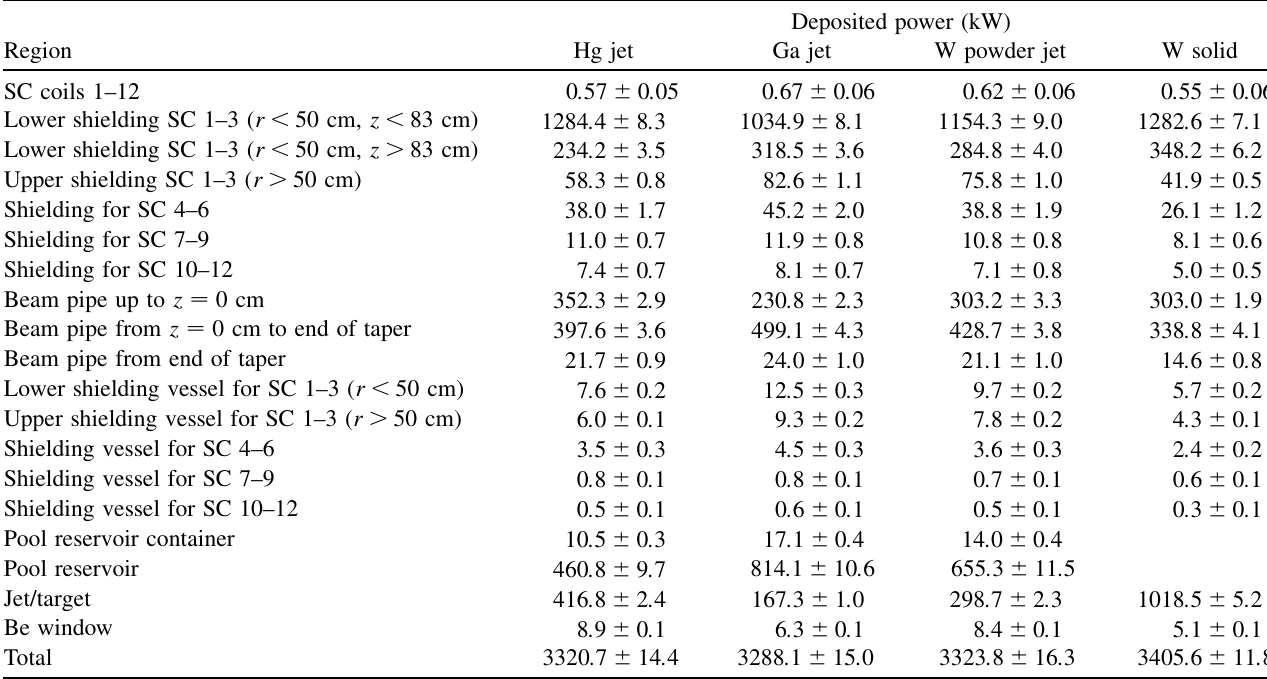
TABLE II. Power deposition in various regions of the increased shielding geometry configuration for the mercury jet, as well as for alternative target materials. For the solid tungsten bars, the pool reservoir is replaced by more shielding.